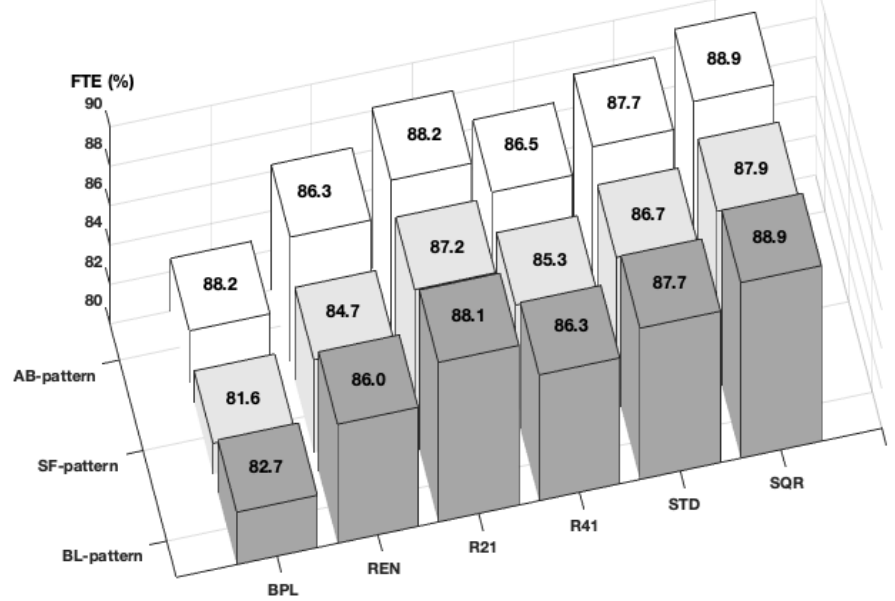
Figure 11. Average FTE for the three selected fieldwork patterns (AB, SF, and BL) in all template field shapes.